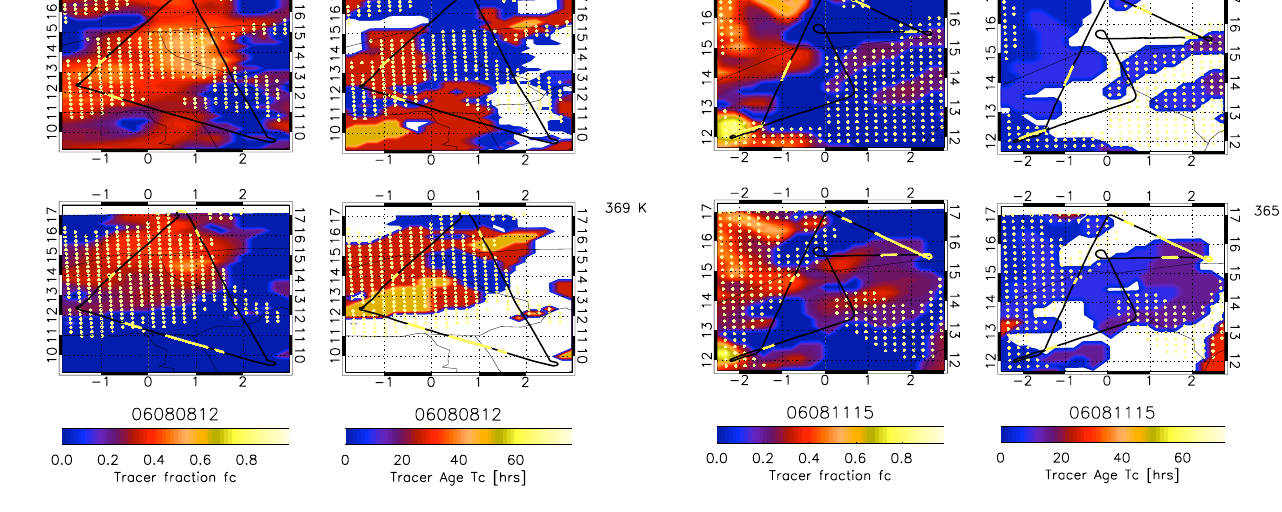
fraction occurs in the northern part of the domain positively correlated to the observed O 3 latitudinal variability reported in Fig. 3 with higher values of O 3 (65 ppbv) observed north of 14 ◦ N. Saturated air (yellow shade) is large and is present also in the upper layer located close to the outflow.